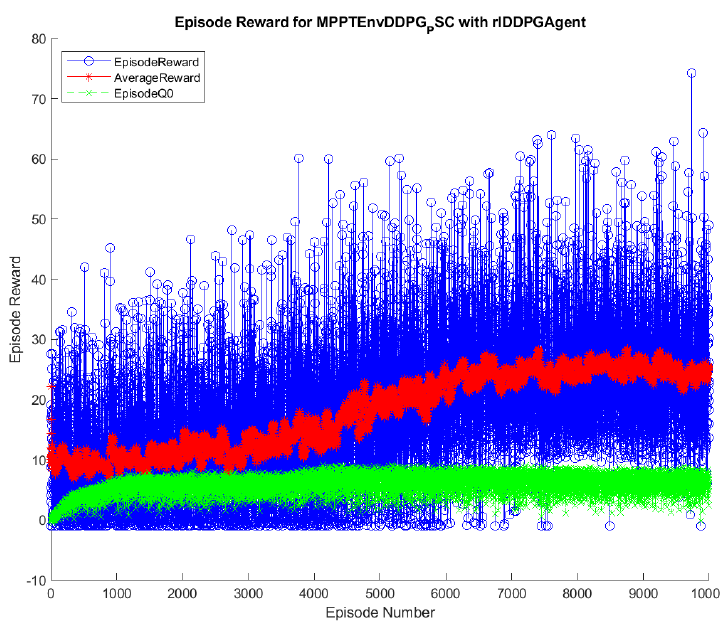
Figure 5. Training process of the DDPG method.